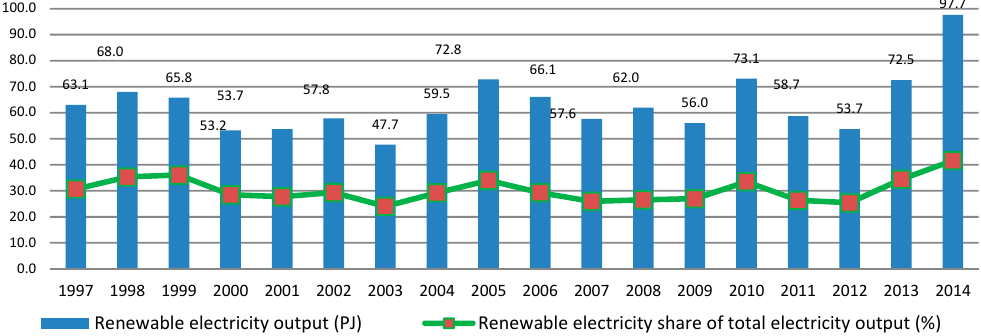
Figure 8. Renewable electricity output evolution (TJ) vs renewable electricity share of total electricity output evolution (%), Source: Own representation based on EUROSTAT and World Bank data [12,24].